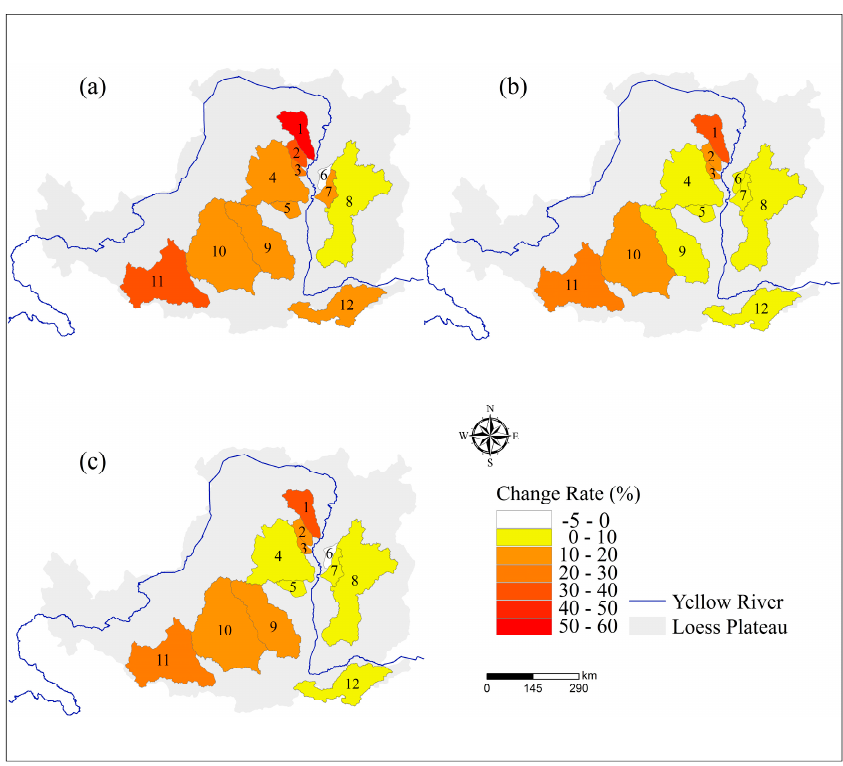
Figure 3. Spatial distribution of elasticity in naturalized runoff to potential evapotranspiration ( a ); precipitation ( b ); and LUCC ( c ) between 1980–1999 and 2000–2013.